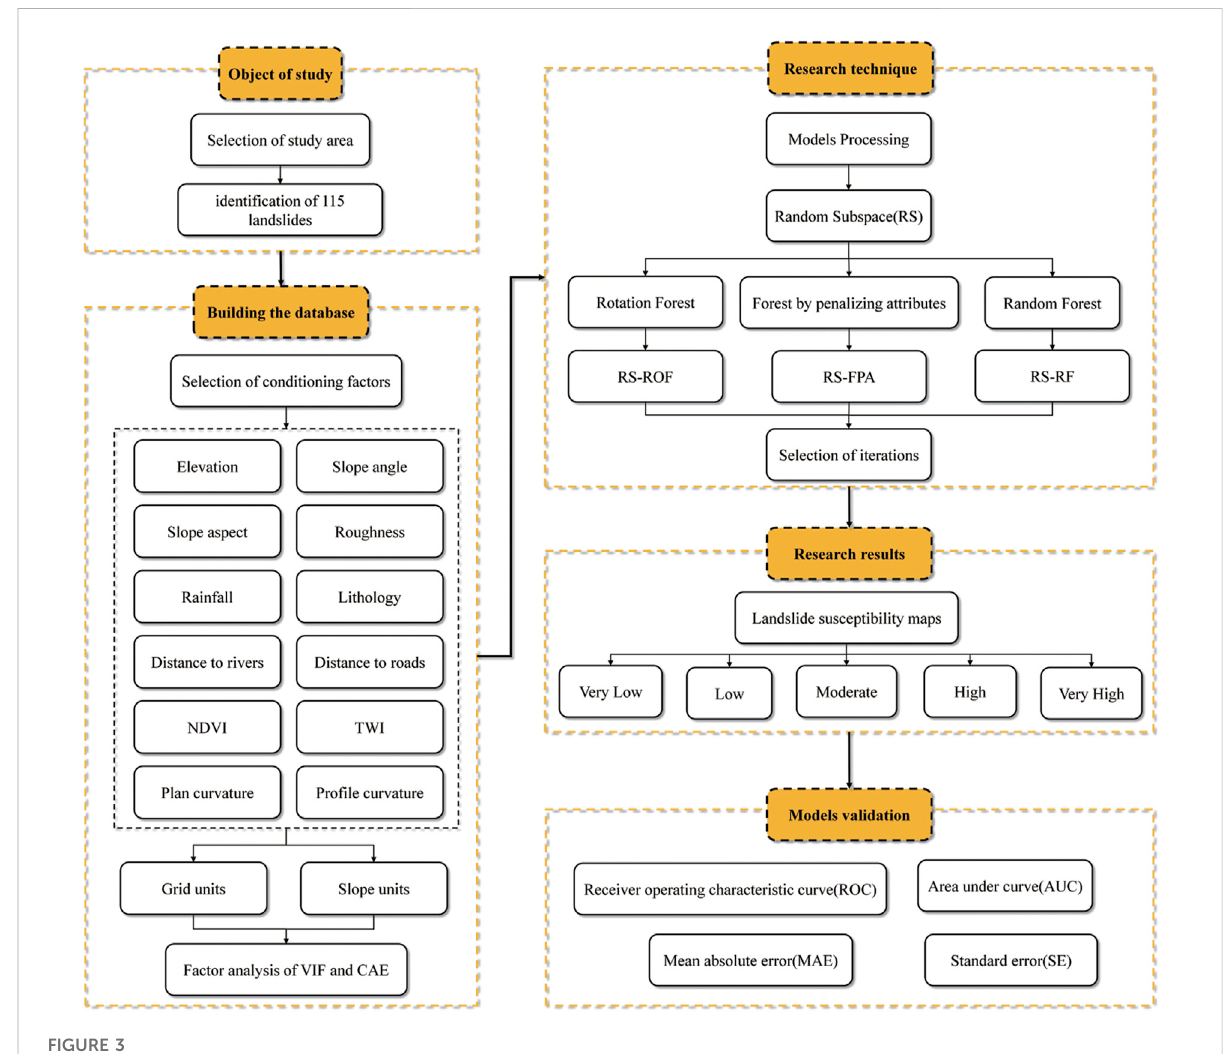
FIGURE 3 Flow chart of the